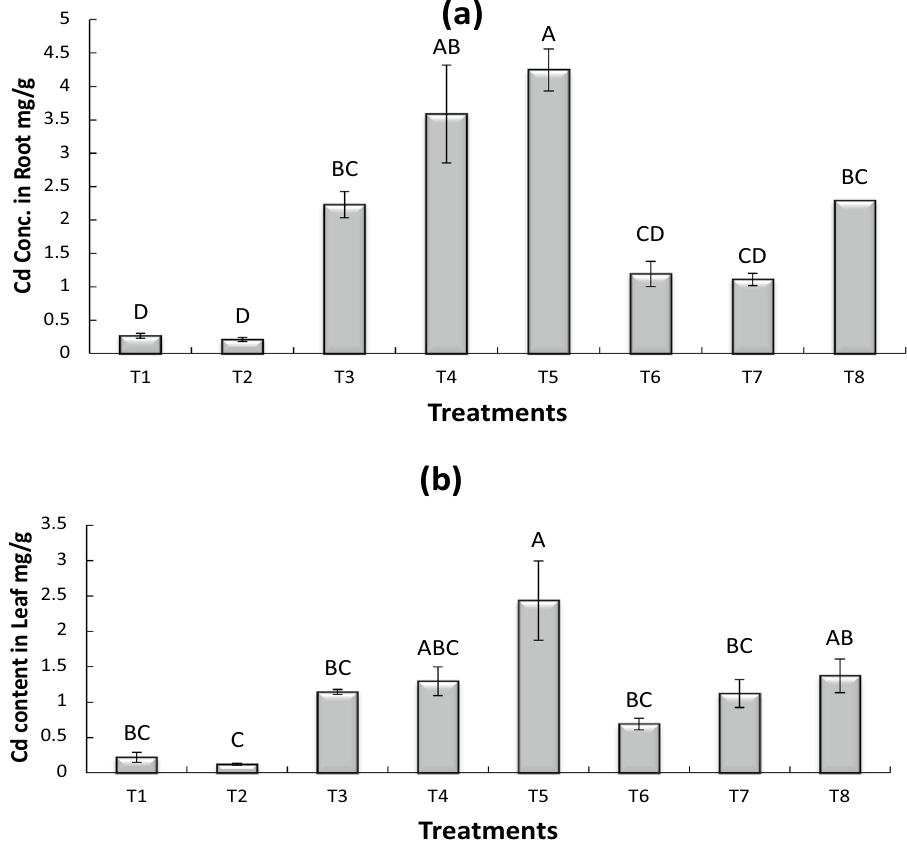
Figure 3. Accumulation of Cadmium (Cd) in maize roots ( a ) and maize leaves ( b ). All treatments sharing common letter with similar bar pattern are similar otherwise differ significantly at p < 0.05. T1 = control, T2 = inoculated seed, T3 = 0.25 mg CdSO 4 100 mL −1 + uninoculated seed, T4 = B = 0.50 mg